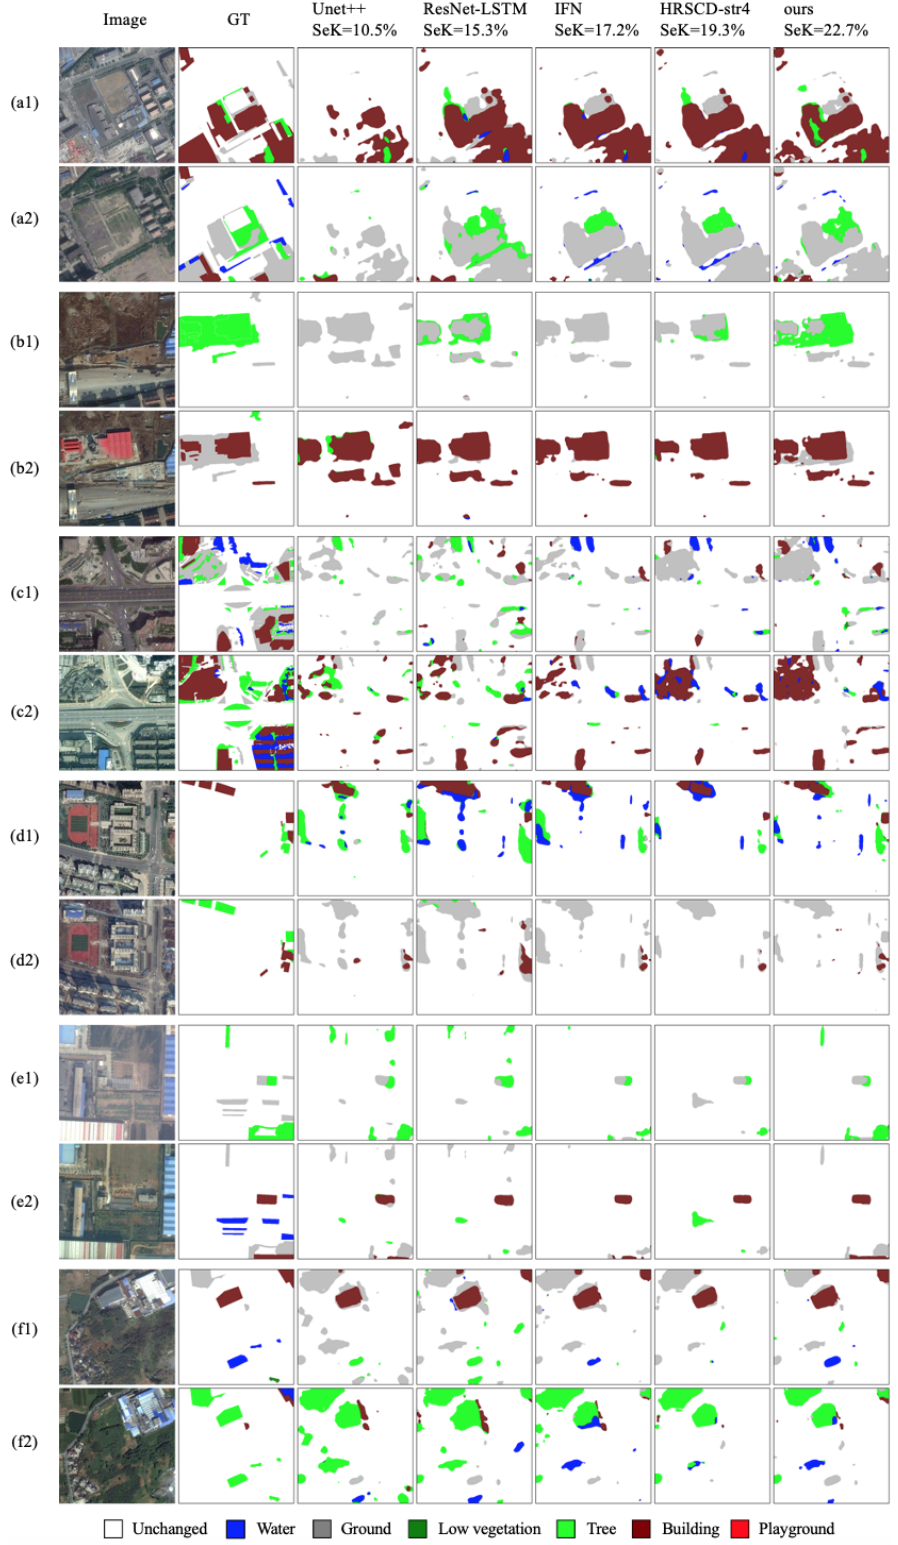
Figure 6. Visualization of several methods on semantic change detection. We also list SeK values of each method over the sample images. Subfigures ( a – f ) are six samples from SECOND